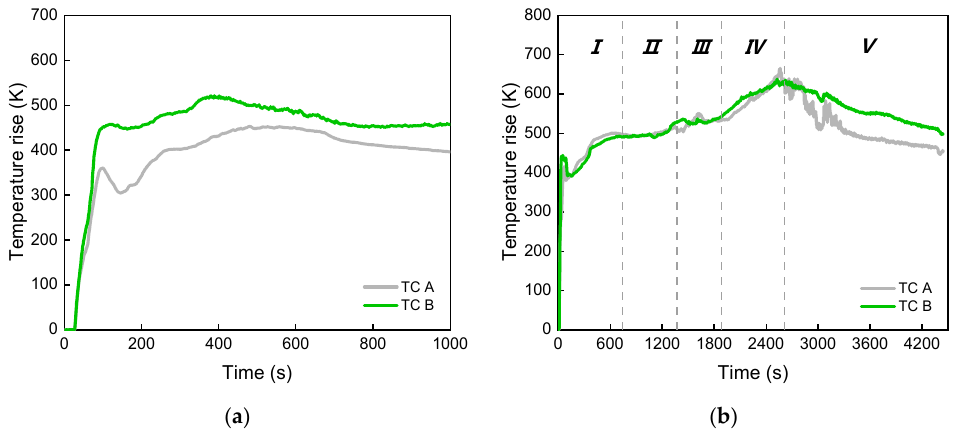
Figure 14. Measured temperatures for Cable ZRC-YJV-8.7/10 3 × 95 mm 2 in: ( a ) Test 1; ( b ) Test 2.